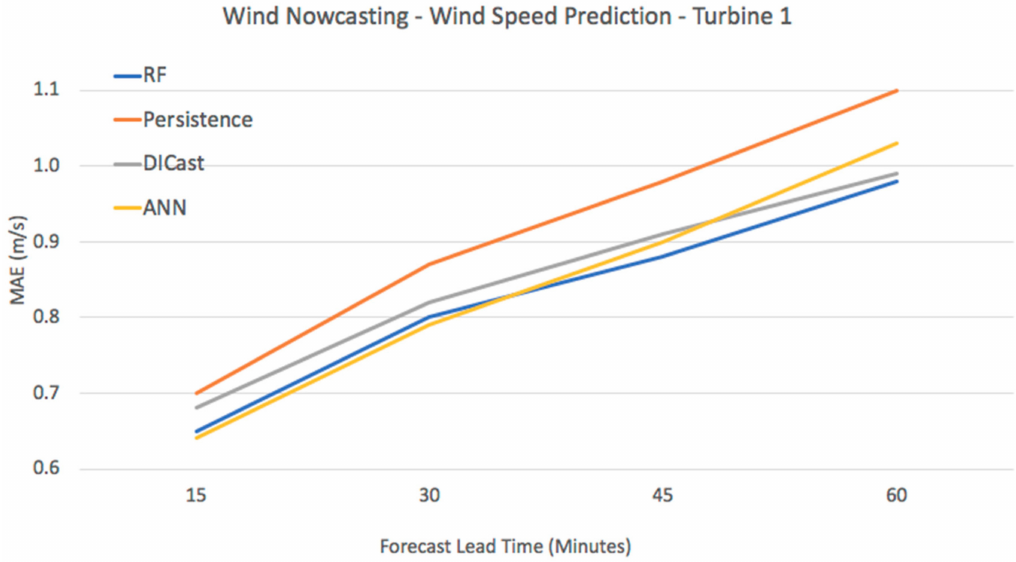
Figure 10. Results (MAE)for the random forest (blue line), ANN (gold line), persistence (orange line), and the DICast hub height wind speed forecast (gray line) in the first 60 min show that the RF improves upon DICast for the first hour and the ANN improves upon DICast for the first 45